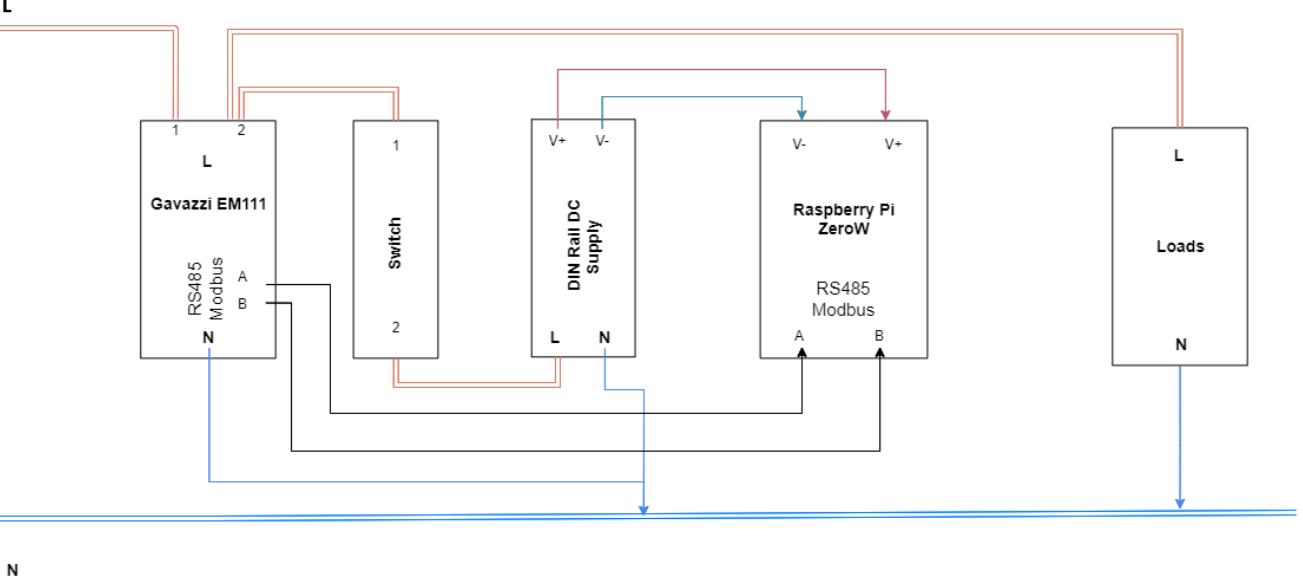
Figure 9. Custom Energy Meter Integrated Solution